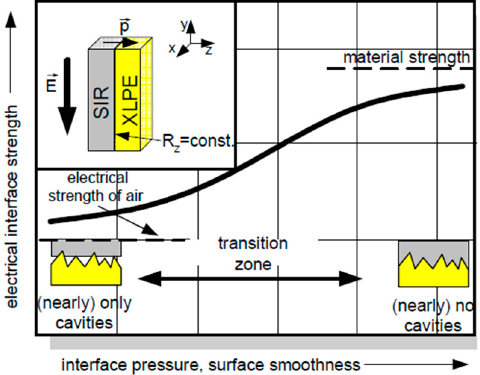
Figure 2. Electrical interface strength has a dependency on the interface pressure [10,14].